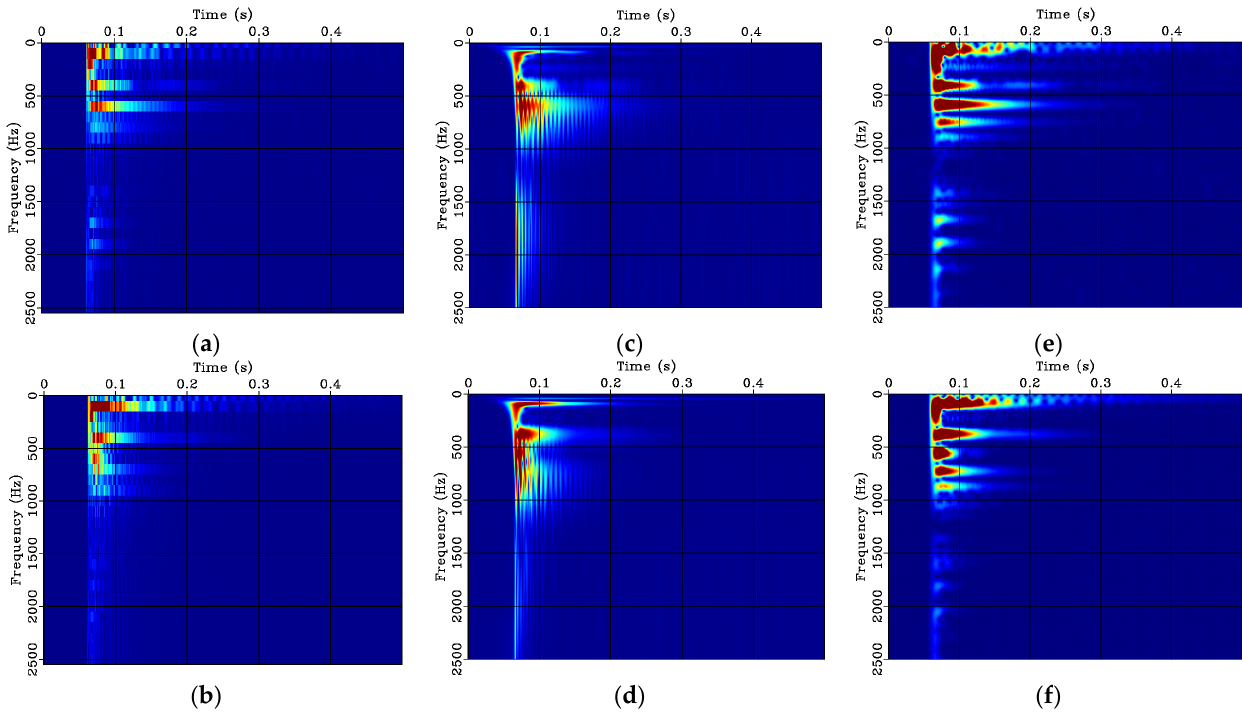
Figure 16. Time-frequency spectrum of un14-2 and cr14-2: ( a ) STFT of un14-2; ( b ) STFT of cr14-2; ( c ) ST of un14-2; ( d ) ST of cr14-2; ( e ) LTFT of un14-2; ( f ) LTFT of cr14-2.